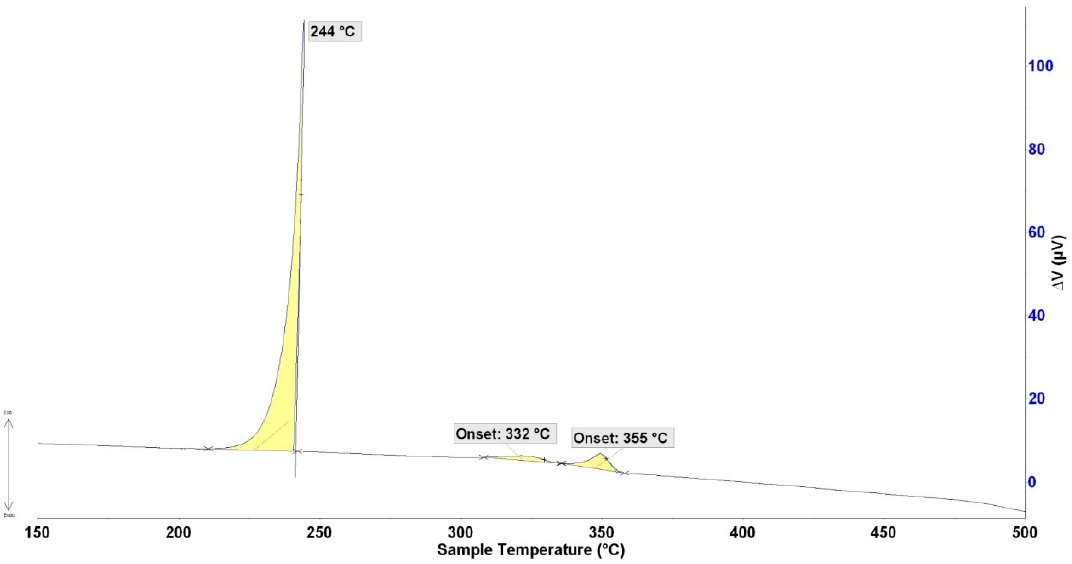
Figure 7. DTA analysis of Bi11Ag1Mg solder, the cooling rate of 5 °C/min. Table 3. Significant phase transformation temperatures were determined by TG/DTA analysis.